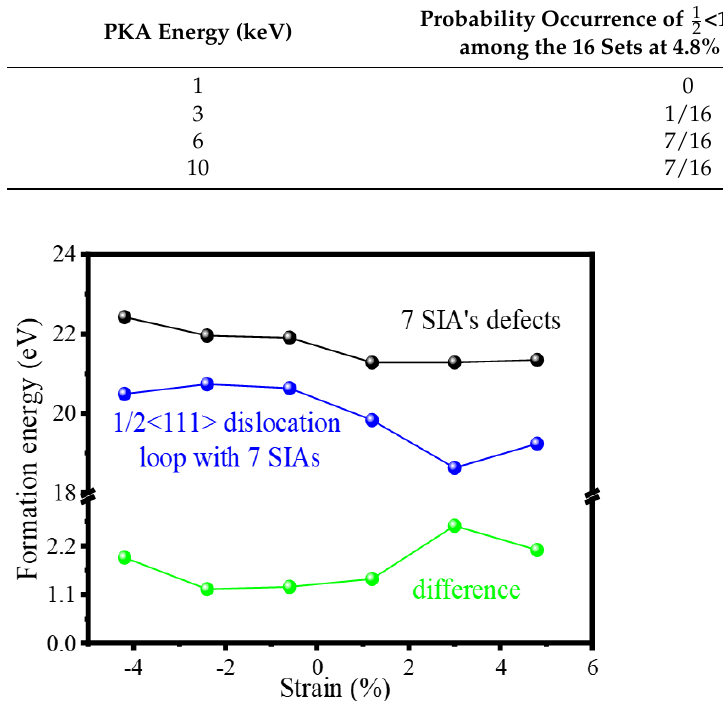
Figure 5. The formation energy of 7 self-interstitial atoms (SIAs) defects as a function of compression and tensile strain is denoted in black. The formation energy of ½<111> dislocation loop with 7 SIAs is denoted in blue. The energy difference between 7 SIAs defects and ½<111> dislocation loop is denoted in green.